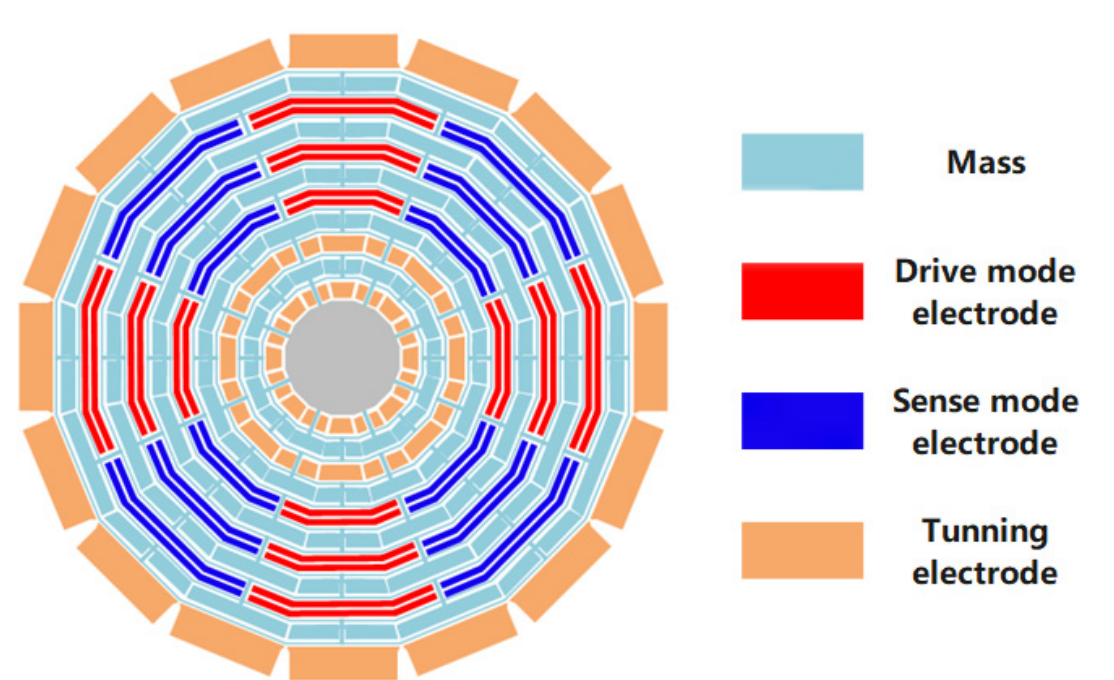
Figure 2. Schematic of a sixteen-sided cobweb-like MEMS gyroscope structure.